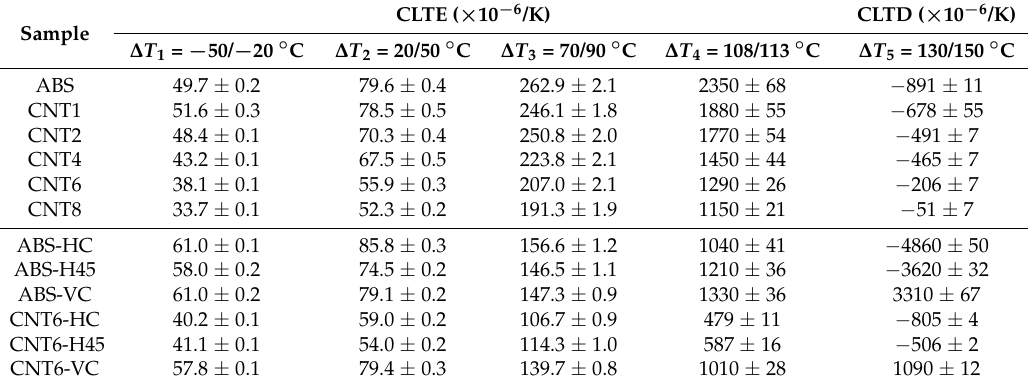
Table 9. Coefficients of linear thermal expansion (CLTE) and linear thermal deformation (CLTD) of ABS and its nanocomposites as measured on filament and FDM samples (see Equation (4) for detail).